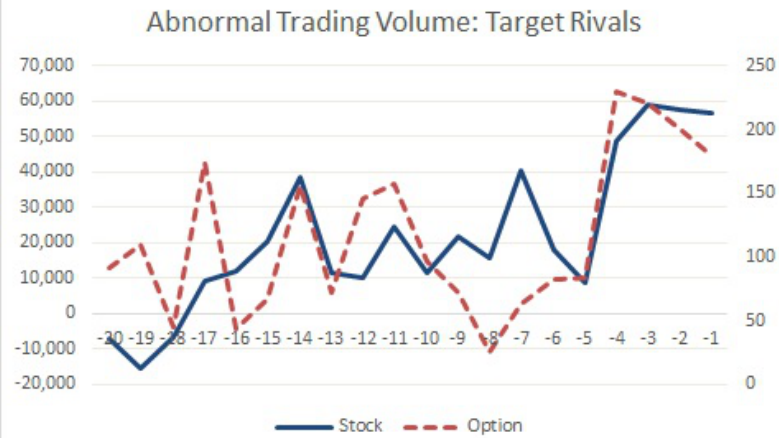
Figure 4. Stock and Option represent the average daily abnormal trading volume of the stocks and options over the 20-day period prior to the announcement for target rivals, respectively.